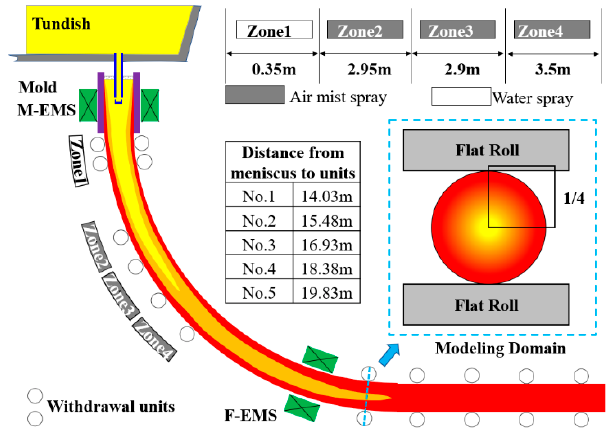
Figure 1. Schematic of continuous casting machine and modeling domain of round bloom.